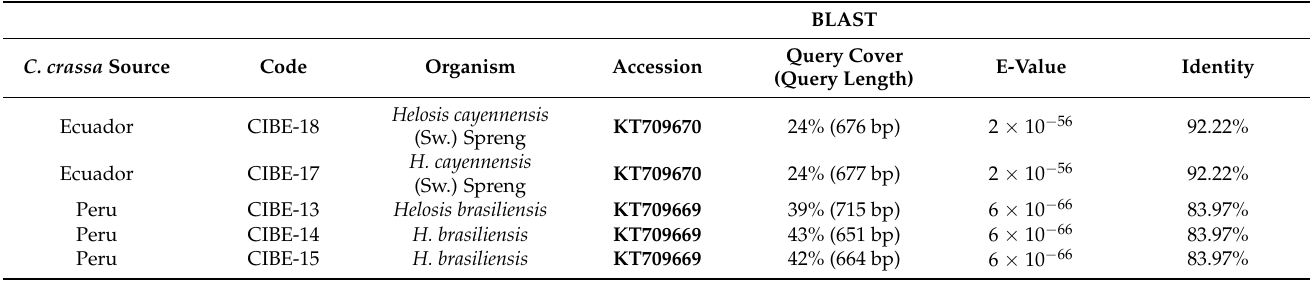
Table 1. Blast analysis of the ITS1 sequences from the C. crassa of Ecuador and